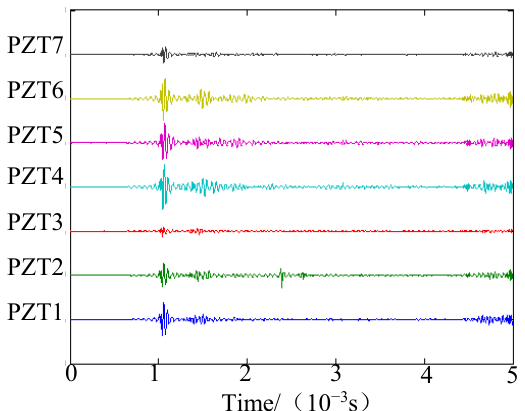
Figure 11. Narrow-band-impact signals.